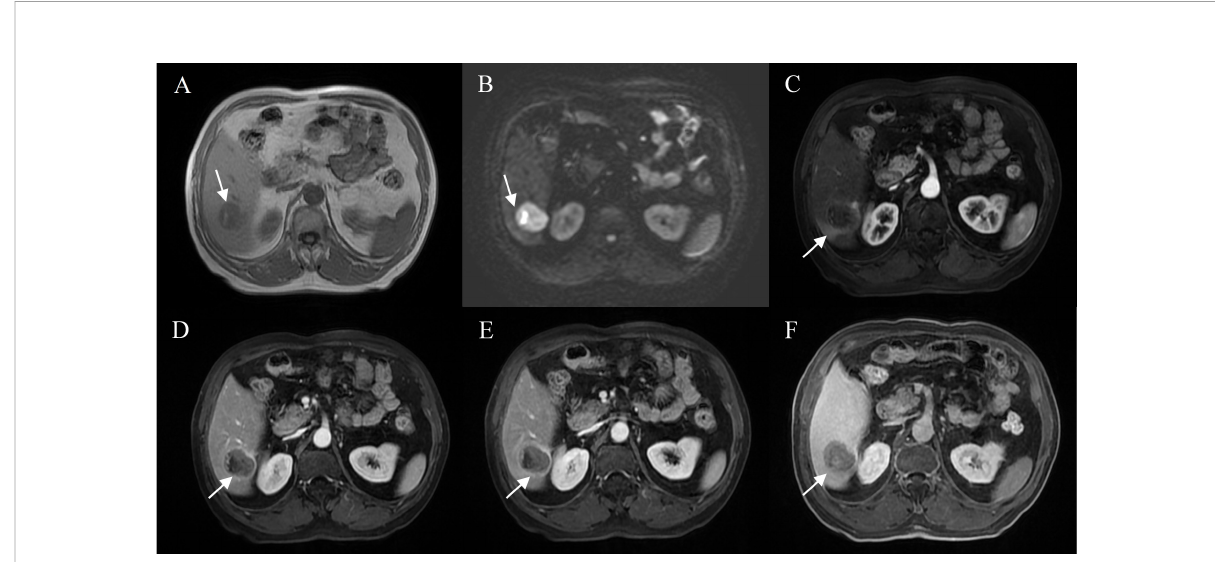
FIGURE 2 Representative images of MVI positive cases: A 71-year-old male with elevated AFP, Gd- BOPTA MRI detected a solid lesion in hepatic segment VI (A) , restricted diffusion (B) , atypical enhancement pattern without “ wash-in ” (C – E) , with the architectures of peritumoral enhancement on arterial phase images (C) , incomplete capsule enhancement on portal venous phase and transitional phase images (D, E) , and peritumoral hypointensity on hepatobiliary phase (F) .